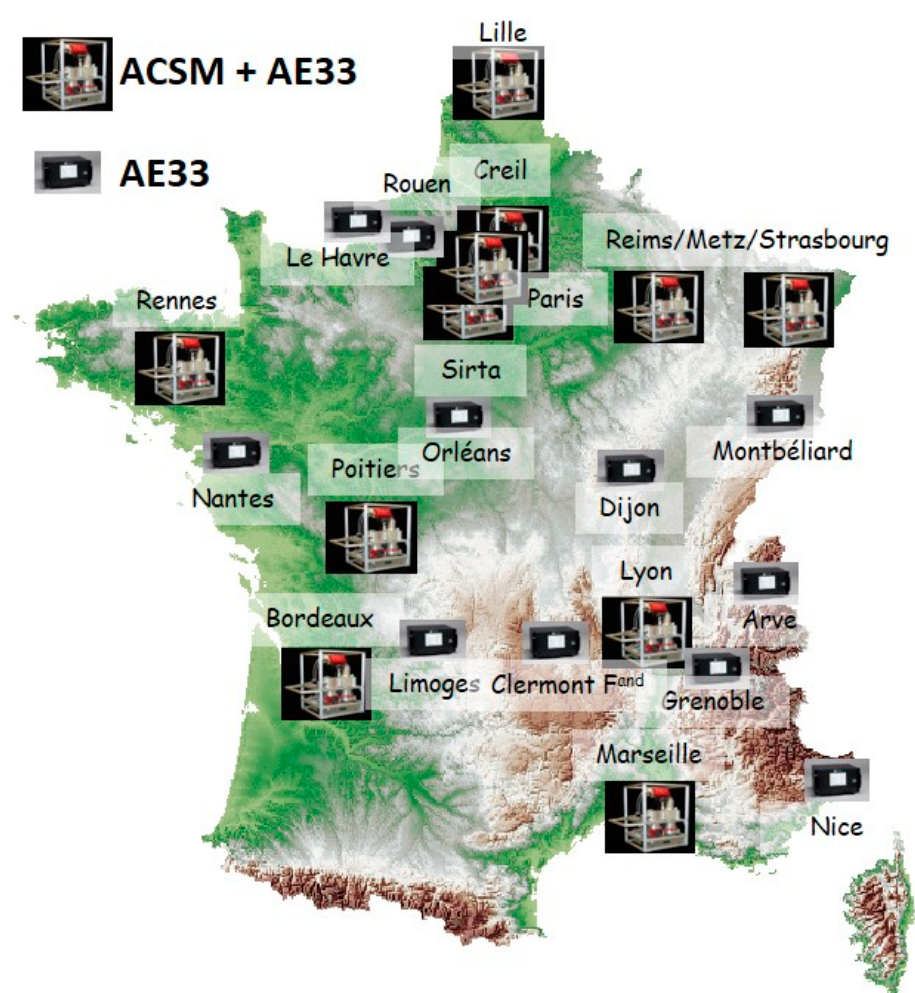
Figure 1. Spatial distribution of the main sites of the CARA program equipped with aerosol chemical speciation monitor (ACSM) and AE33, or with AE33 only (non-exhaustive), in 2020.